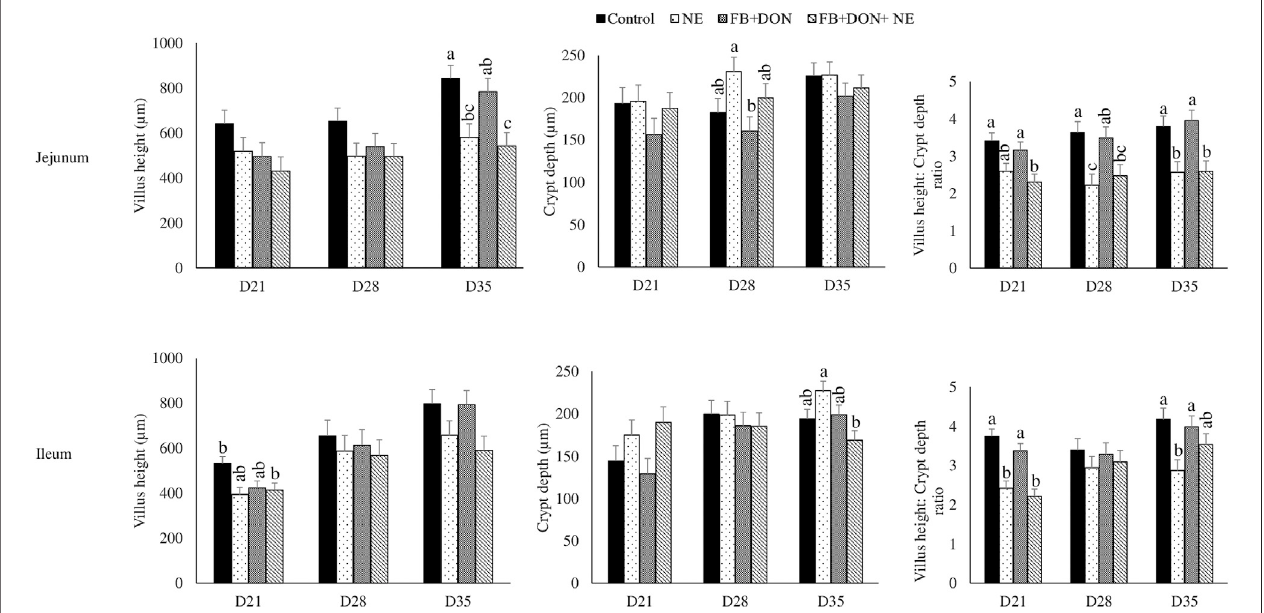
FIGURE 6 | Effect of subclinical dose of FB + DON and E. maxima/C. perfringens challenge on jejunal and ileal histomorphology. Day-old chicks were distributed into four treatment groups: control, necrotic enteritis (NE), fumonisin + deoxynivalenol (FB + DON), and FB + DON + NE groups. Birds in the NE and FB + DON + NE groups received2.5 ×10 3 Eimeriamaxima oocystper bird on day 14.All birds received 1×10 8 CFU/bird of Clostridium perfringens on days 19, 20,and 21.Jejunal and ilealsectionswerestainedwithhematoxylinandeosin.VilliheightandcryptdepthweremeasuredusingcellSensImagingsoftware,andvilliheight:cryptdepthratio was calculated. Bars (+SEM) without a common superscript differ signi fi cantly ( p < 0.05). n = 8 (8 pens of 15 birds/pen).